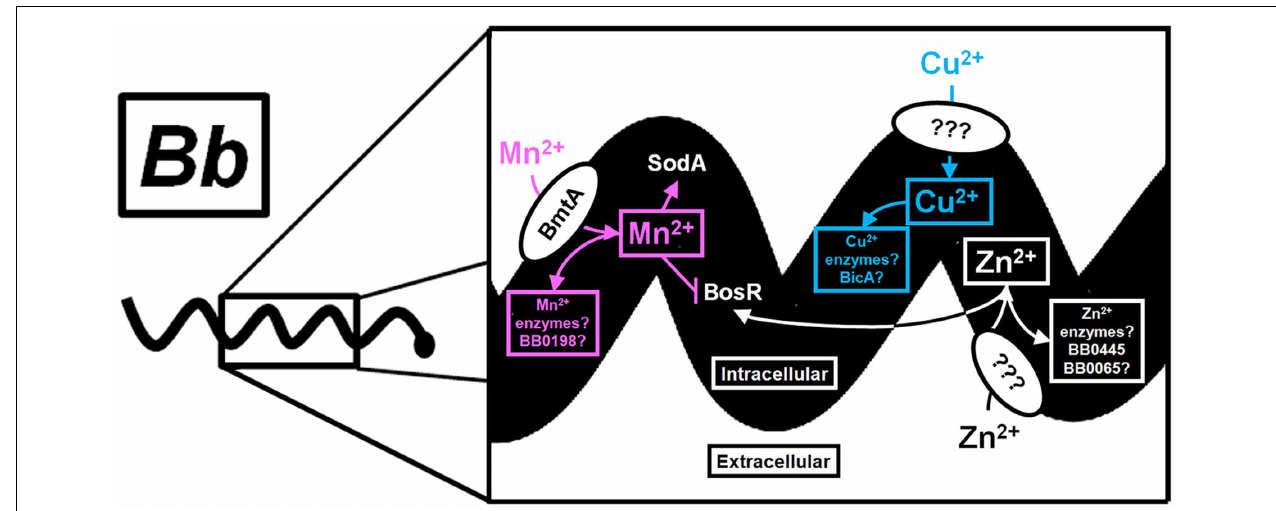
Bb is likely to include enzymes within glycolysis, such as fructose 1,6-bisphosphatase (BB0445), and the peptide deformylase (BB0065) shown in the white box. Zn 2 + is a known cofactor for the DNA binding protein BosR. Therefore, the intracellular Mn 2 + :Zn 2 + can modulate the level of BosR protein. The transporter for Cu 2 + and the role of Cu 2 + within Bb is unknown, but BicA may be involved in transport and homeostasis (blue box). Moreover, the contribution of Cu 2 + to gene regulation within Bb is unknown, but is predicted to involve redox sensing transcription factors (Changela et al., 2003; Gomez-Santos et al., 2011). Future work is required to elucidate the complete role of these metals in gene regulation and physiology of this important vector borne